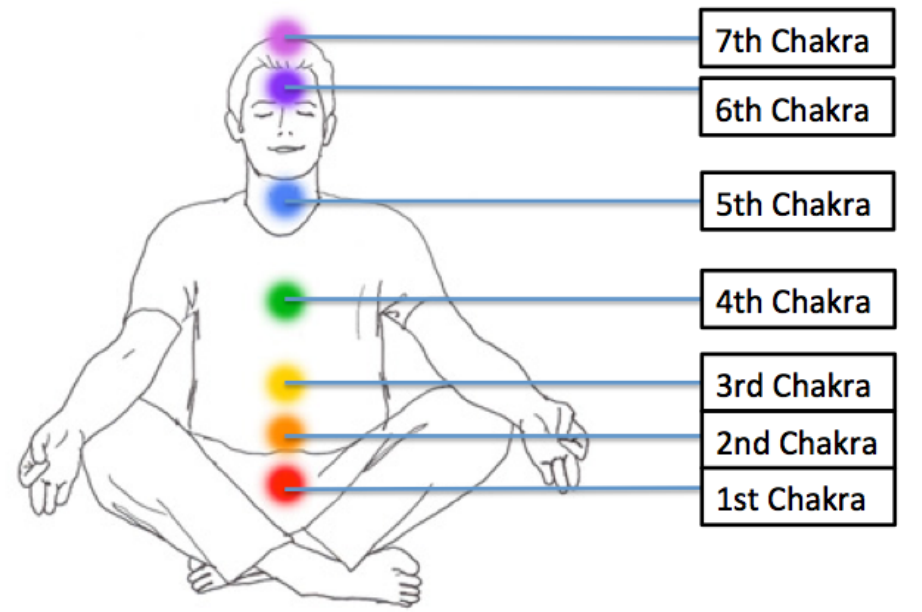
Figure 1. Diagram of the